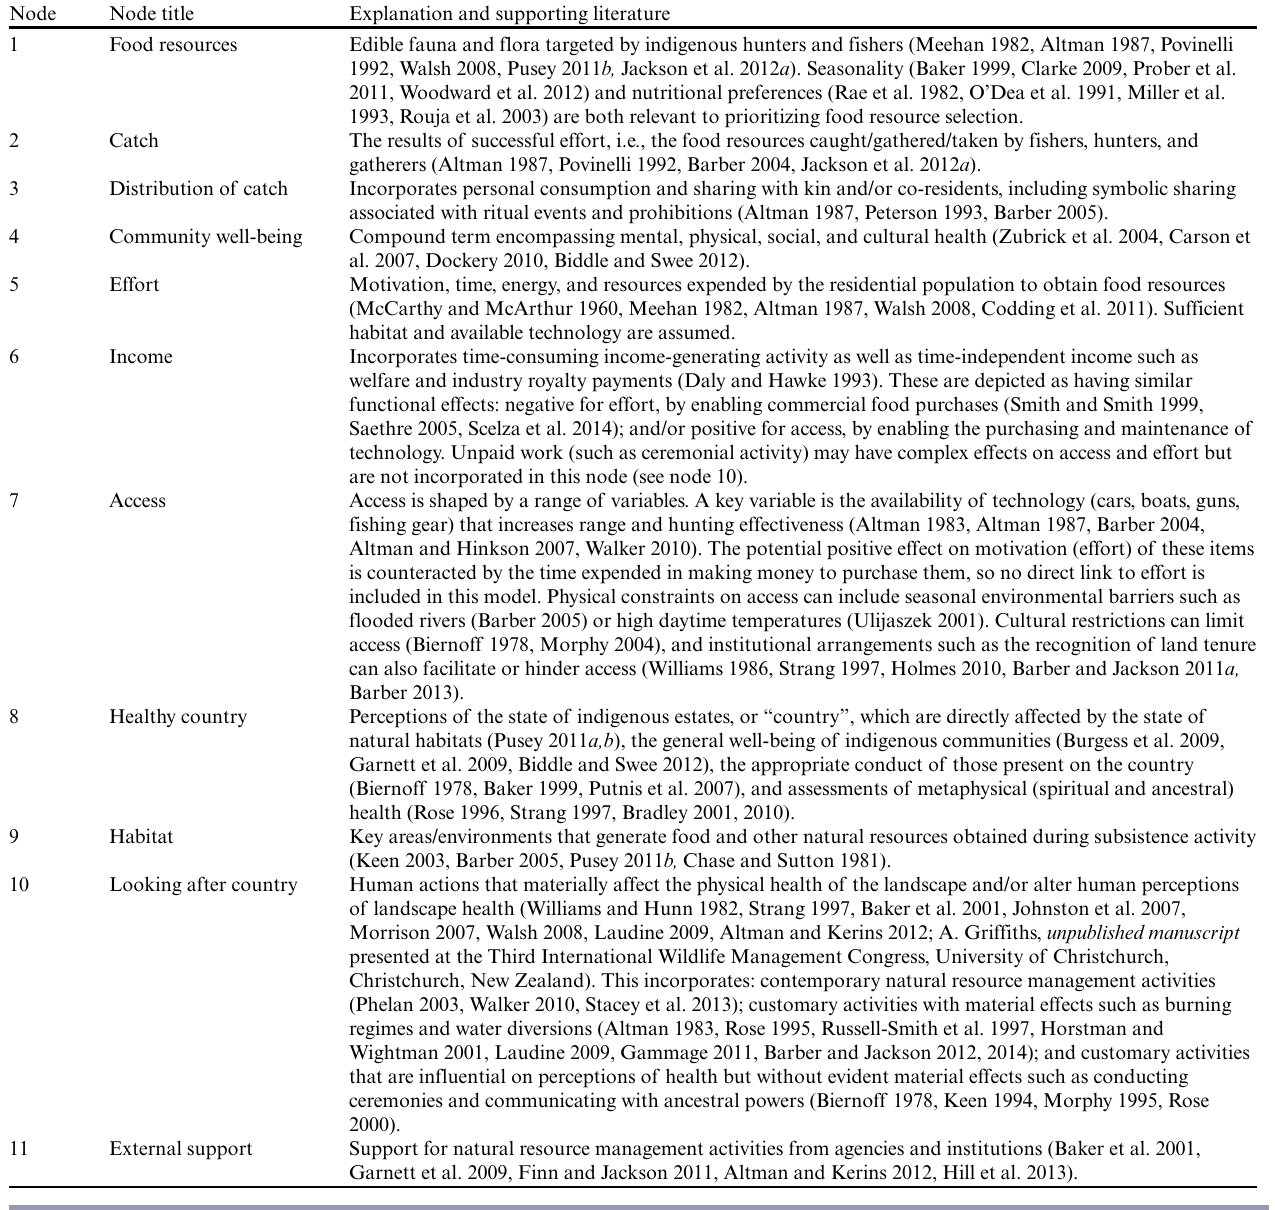
Table 1. Definition of nodes in model